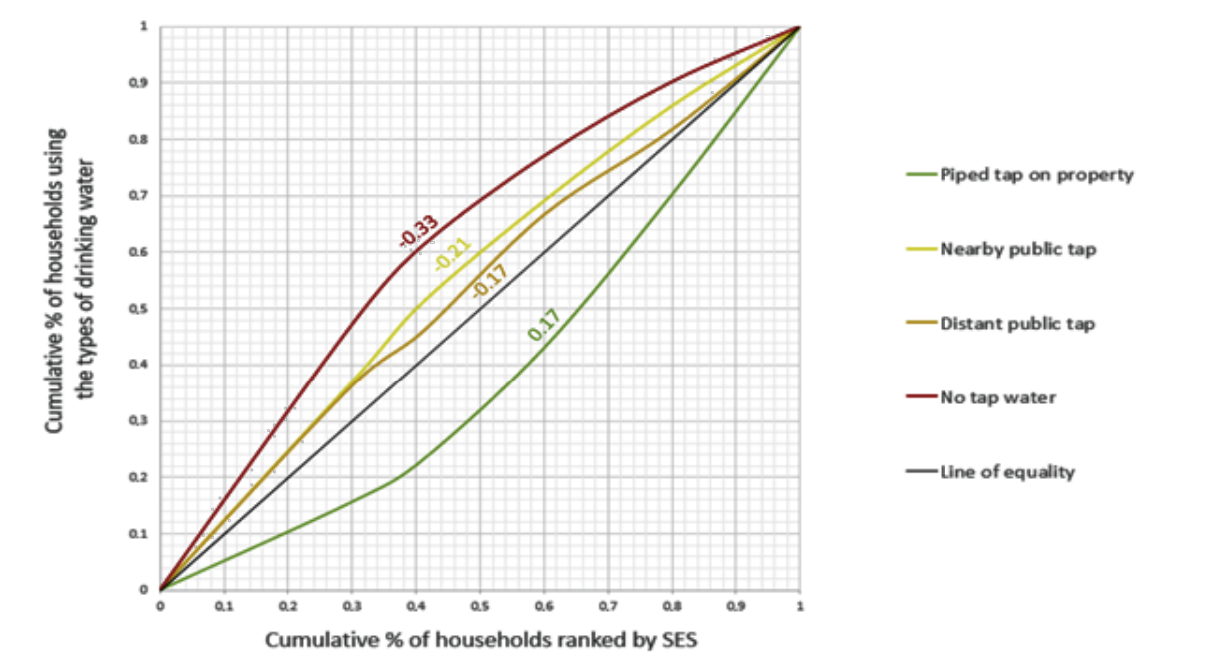
Figure 3. Socio-economic inequalities in the use of drinking water as represented by concentration curves, with corre- sponding concentration indices displayed alongside the graphs; SES = socio-economic status.